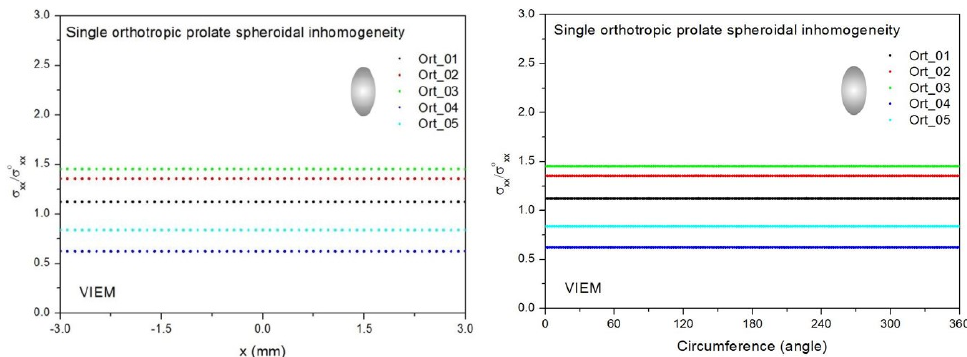
Figure 14. VIEM results for the normalized tensile stress component ( σ xx / σ oxx ) along ( left ) the x–axis inside and ( right ) the circumferential direction of the orthotropic prolate spheroidal inclusions (Ort_01, Ort_02, Ort_03, Ort_04 and Ort_05) with a/b = c/b = 0.5 (b = 6 mm) under uniform remote tensile loading.